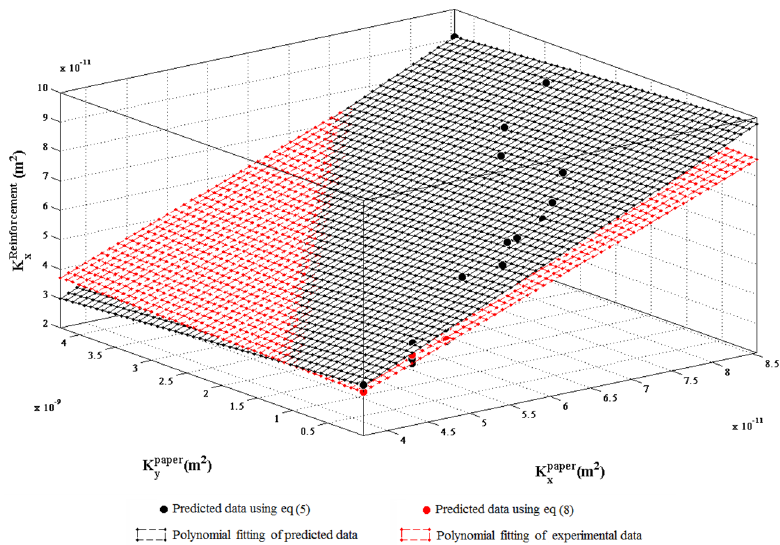
Figure 9. Comparison between experimental data and predicted K x using Equations (5 and 8).